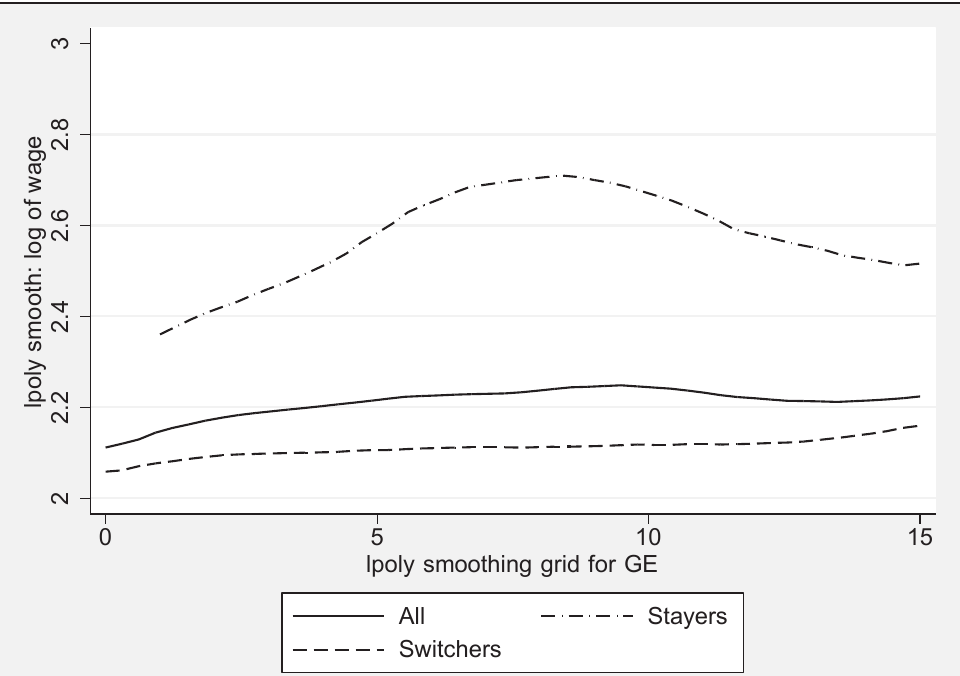
Kernel-weighted local polynomial – returns to general experience, employ- ment principals